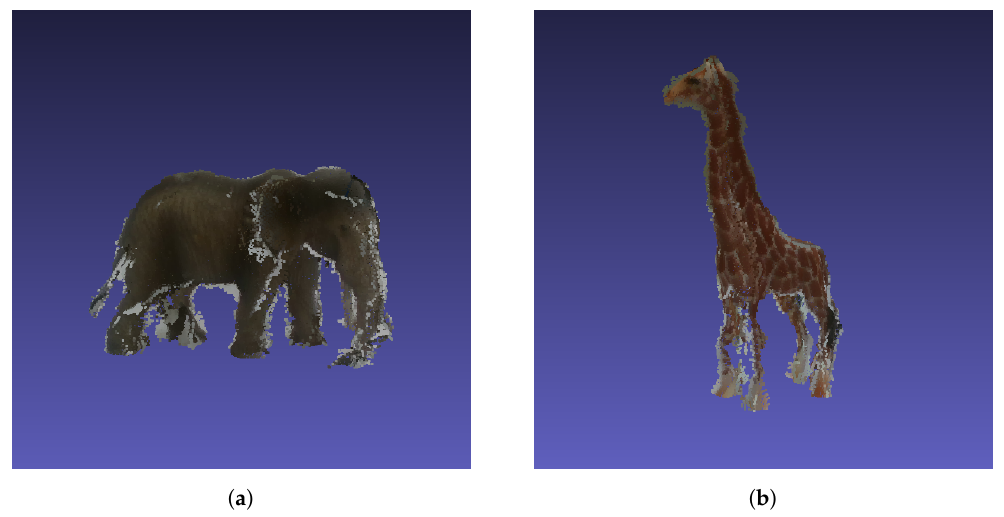
Figure 1. Two example point clouds to visualize the quality of the generated 3D-models. We are able to capture the correct physical dimension of the object and its overall characteristics. The physical extends are 8.2 × 15.3 × 9.0 cm 3 and 4.7 × 9.4 × 1.6 cm 3 for the elephant and the giraffe respectively. ( a ) Point cloud of our elephant toy figure. ( b ) Point cloud of our giraffe toy figure.